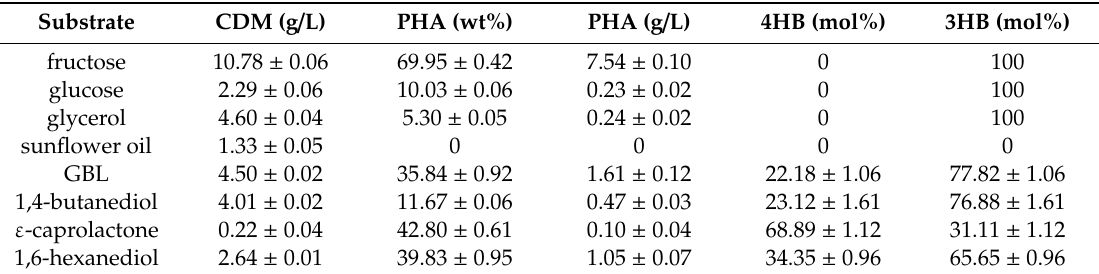
Table 1. Substrates for P3HB and P(3HB- co -4HB) production by Cupriavidus sp. DSM 19379.